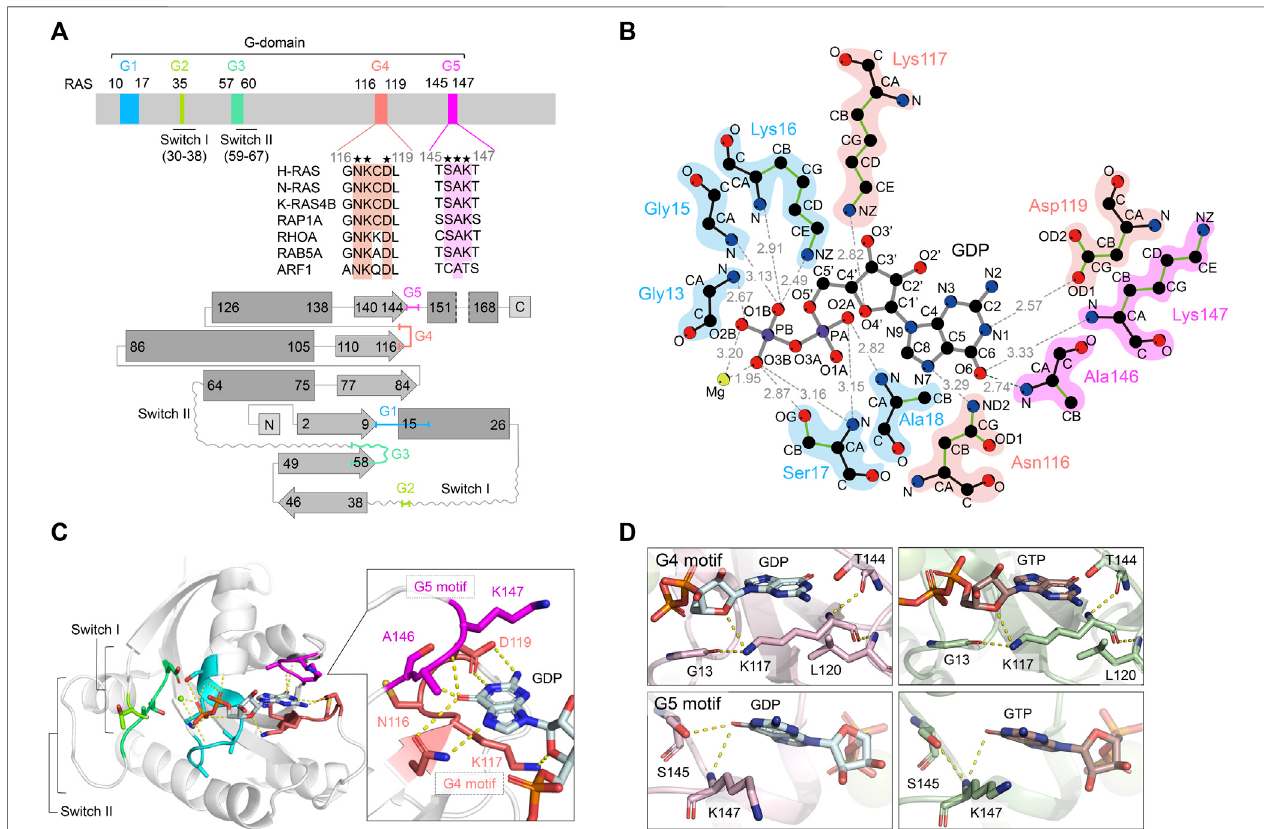
FIGURE 1 | Overview of RAS structures and the guanine nucleotide-dependent interactions of G4 and G5 motifs. (A) A schematic diagram of the RAS G-domain. Upper: Multiple sequence alignment ofthe RAS isotype G4 and G5motifs and representative RAS superfamily members are shown. Conserved residues are annotated by asterisks. Lower: the secondary structures and topology ofRAS. α -helices and β -sheets are shown in rectangle and arrow shape, respectively. Color theme for each Gmotif(G1:cyan,G2:lightgreen,G3:green,G4:coralpink,G5:magenta)areconsistentthroughoutthe fi gures. (B) InteractionofH-RASG-motifswithGDP(PDB: 4Q21) with hydrogen bonds. The plots were generated by LigPlot (Wallace et al., 1995) and the modi fi ed for clarity. The hydrogen bonds are shown in gray dotted lines withthedistancebetween atoms.For aminoacid residues, the mainchains areshown in black, and the sidechains areshown in green. Each atomisshown inasphere and coloredasfollows: carbon,black; oxygen,red;nitrogen, blue; phosphorous, purple;magnesium,lime yellow. (C) Thecrystalstructure ofGDP-boundH-RAS (PDB: 4Q21). The hydrogen bonds are shown asdotted lines and Mg 2+ ion as apurple sphere. Protein isshown as gray helix and the interactingresidues ofG4 and G5motifs with the guanine moiety are shown in licorice representation in the inset. (D) Interactions of Lys117 within the G4 motif (upper panels) and Lys147 within the G5 motif (lower panels) with GDP-bound K-RAS (PDB: 6MBT) (left panels) and GTP-bound K-RAS (PDB: 5VQ2) (right panels). Hydrogen bond interactions are shown as dotted lines. Protein is rendered as cartoon and residues interacting with Lys117 or Lys147 are shown in licorice representation.